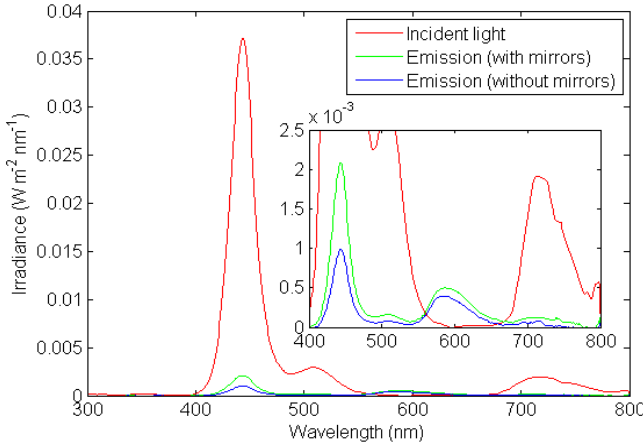
Figure 16. Experimental measurement result.